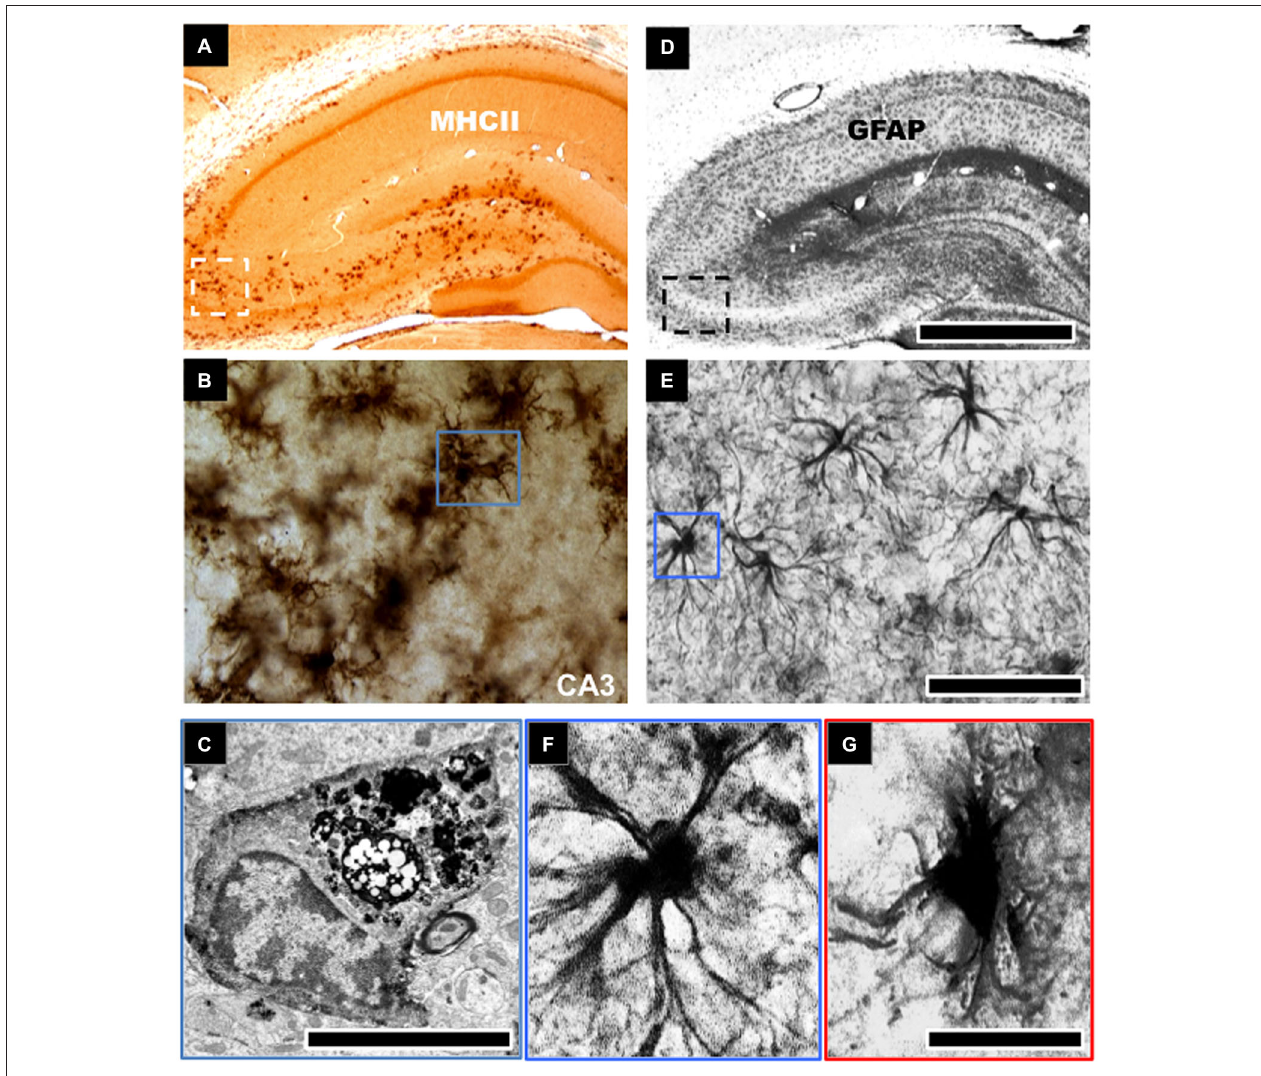
intense electron dense staining for phagolysosomes following electron microscopic examination (C) . Astroglial cells in aged hippocampus become hypertrophic and increase their expression of glial fibrillary acid protein (GFAP), a marker of astrogliosis (D,E) . These cells demonstrate an enlarged cell body and reduced cellular processes (F,G) . Scale bar in (D) represents 733 µ m in (A,D) ; 65 µ m in (B,E) ; and 7.25 µ m in (F,G) . Scale bar in (C) represents 1.25 µ